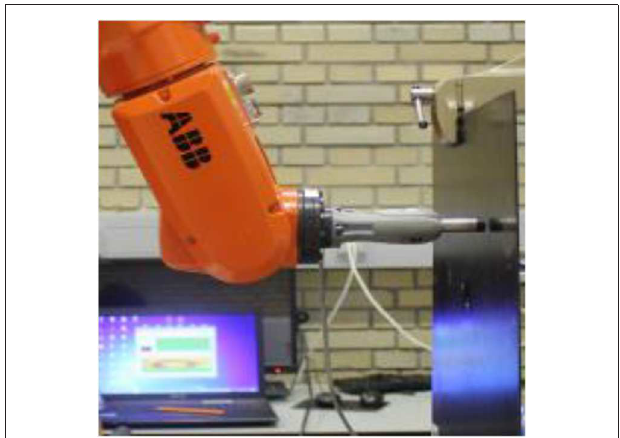
FIGURE 7 | Robotic scanning setup.